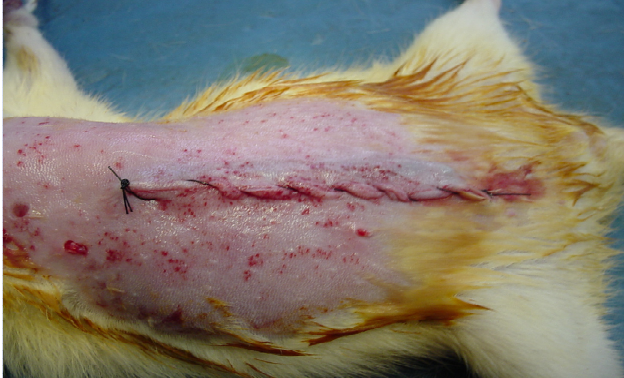
FIGURE 2 – Suture of the skin